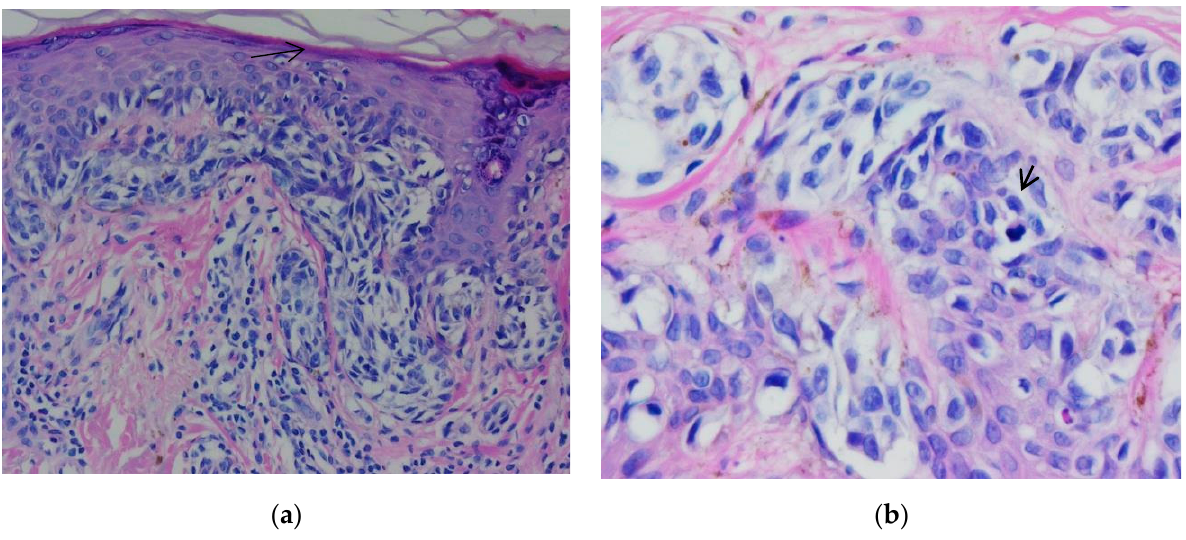
Figure 4. Superficial spreading melanoma. ( a ) Asymmetric tumor proliferation is observed beneath the epidermis (10× magnification). The tumoral cells are organized in nests. They are seen at the junction and extending into the depth of the dermis. Pagetoid migration is observed (arrow). ( b ) Tumor cells are organized into nests and show high atypia (40× magnification). Mitoses are seen (arrow). (Collection of Pathology Department SCJ Mure ș ).